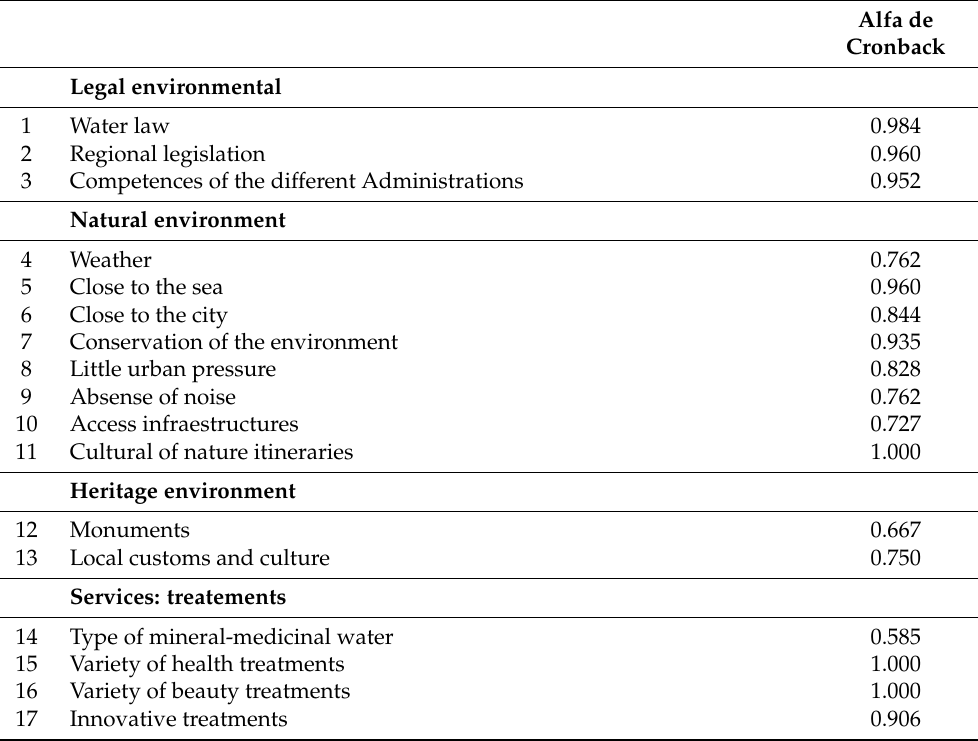
Table 2. Internal reliability of the questionnaire (Cronbach’s alpha) ( n = 6 a